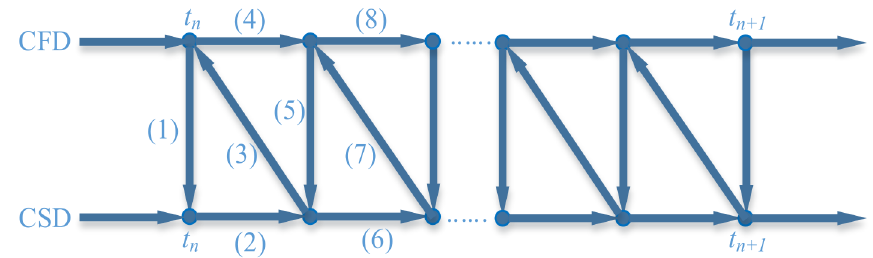
Figure 6. Coupling method 3 between aerodynamics and structural dynamics.